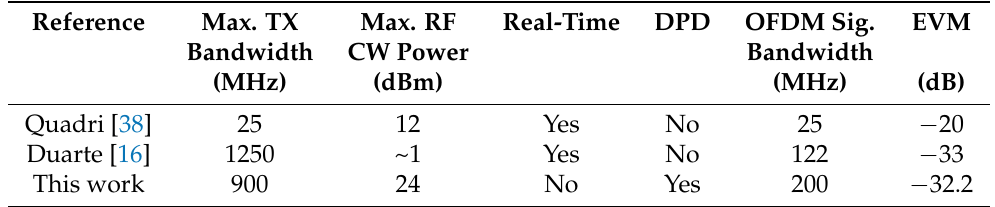
Table 1. 60 GHz test-bed comparisons. TX: transmitter; RF: radio frequency; DPD: digital predistor- tion; OFDM: Orthogonal Frequency Division Multiplex; EVM: Error Vector